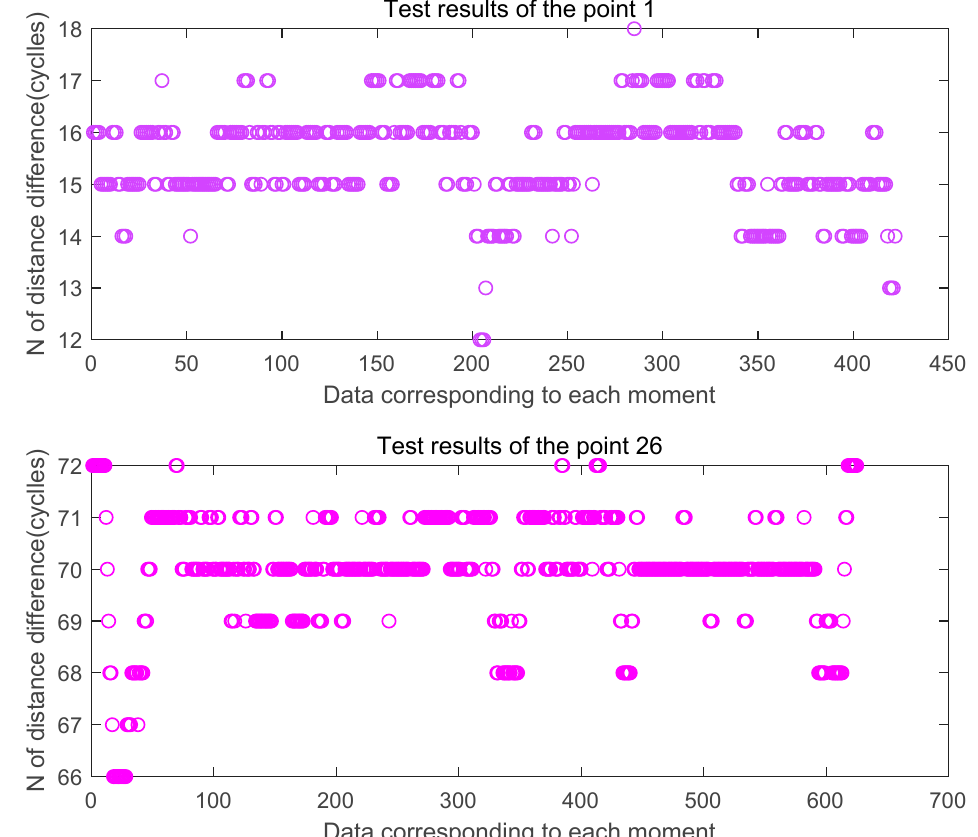
Figure 15. Estimated distance difference N at the three feature points in the second set of tests.